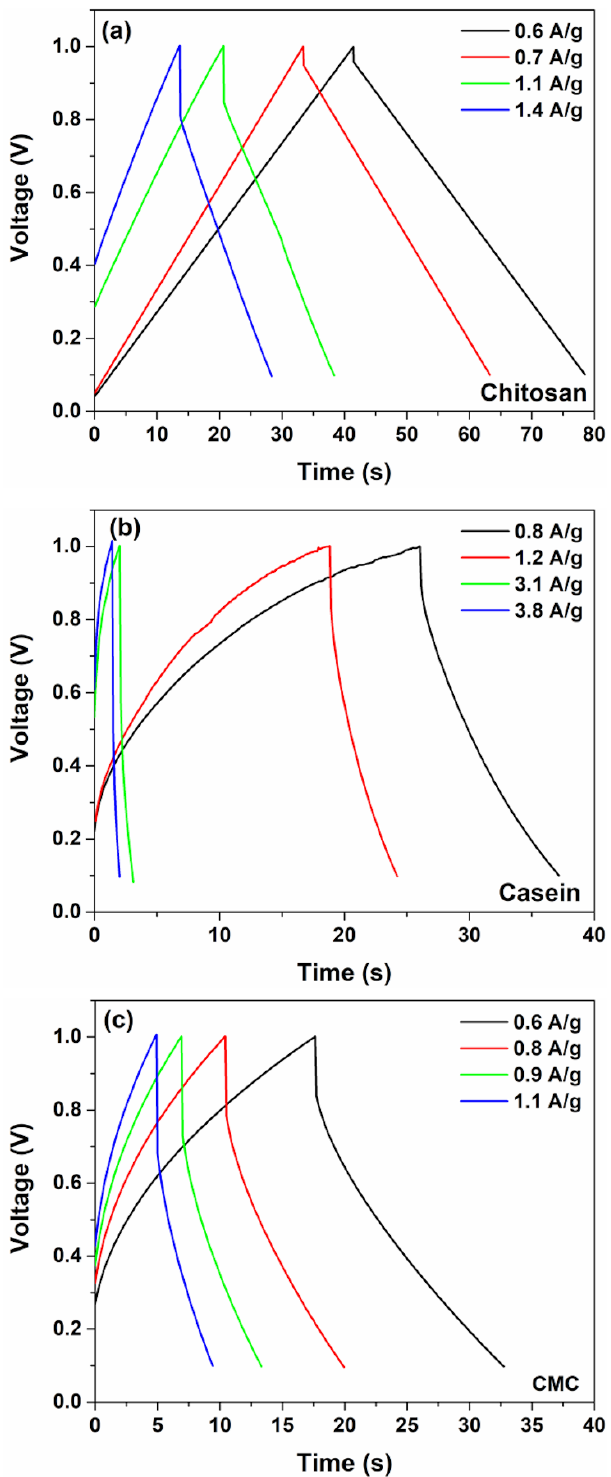
Figure 4. Galvanostatic charge and discharge curves at various current densities for the supercapacitors based on ( a ) chitosan, ( b ) casein and ( c ) CMC with 2 M NaCl gel polymer electrolyte, respectively.